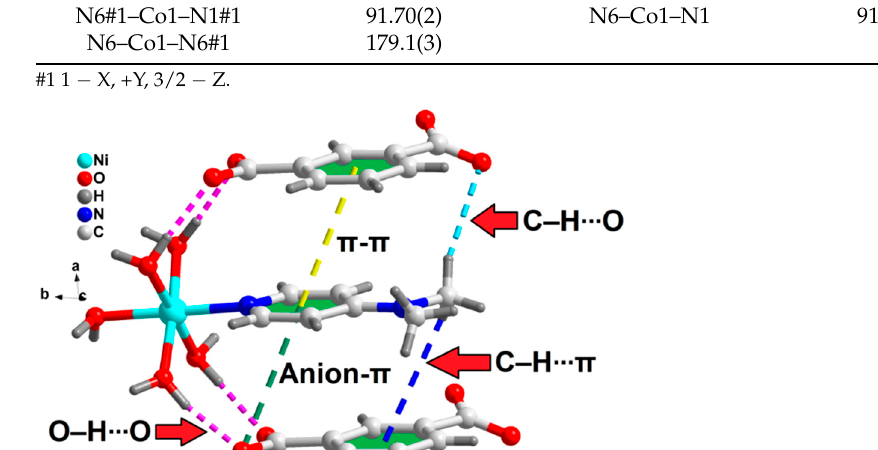
Figure 2. Formation of a supramolecular trimer in compound 1 assisted by O ‒ H···O, C ‒ H···O hy- drogen bonding, non-covalent C ‒ H··· π , anion- π and π - π interactions.